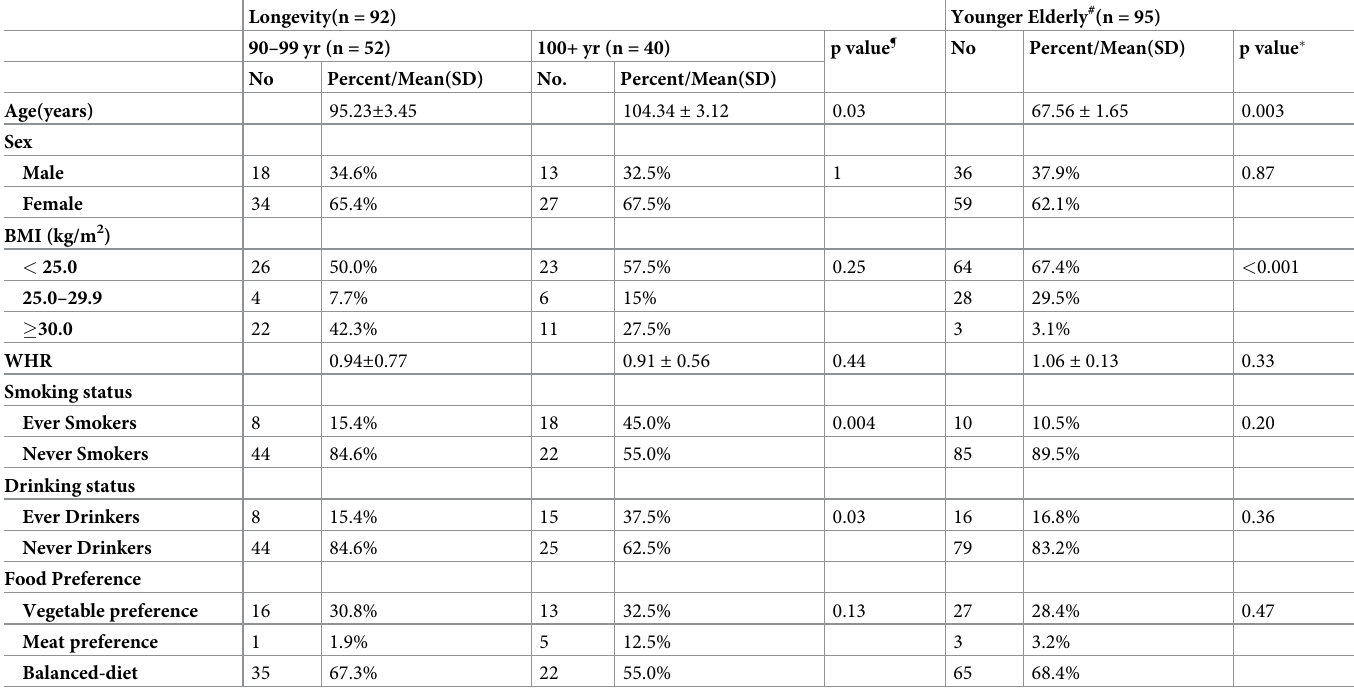
Table 1. Distribution of demographic characteristics according to